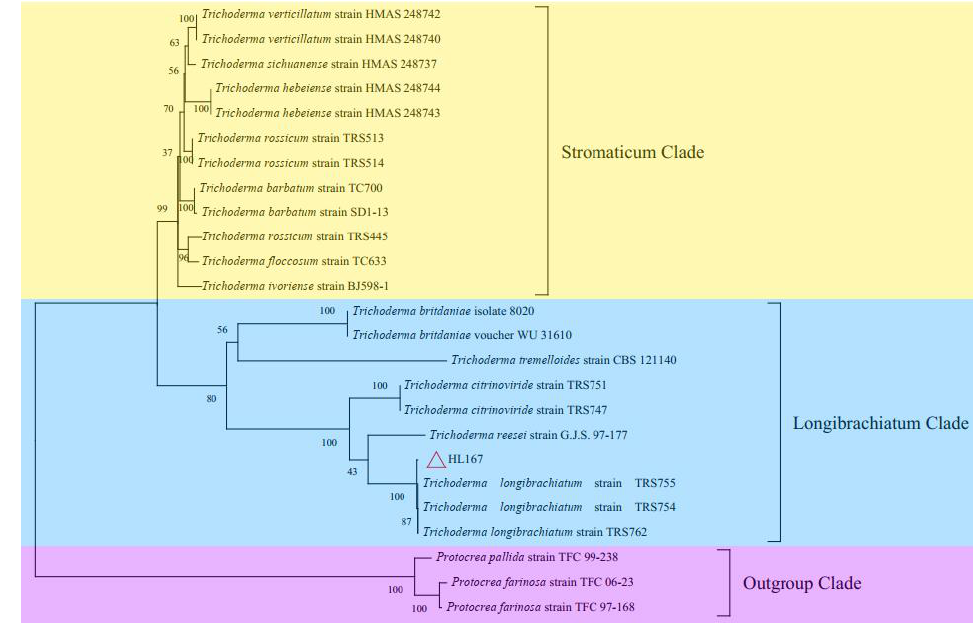
Figure 4. Phylogenetic tree of Trichoderma HL167 based on TEF1 and RBP2 sequences.